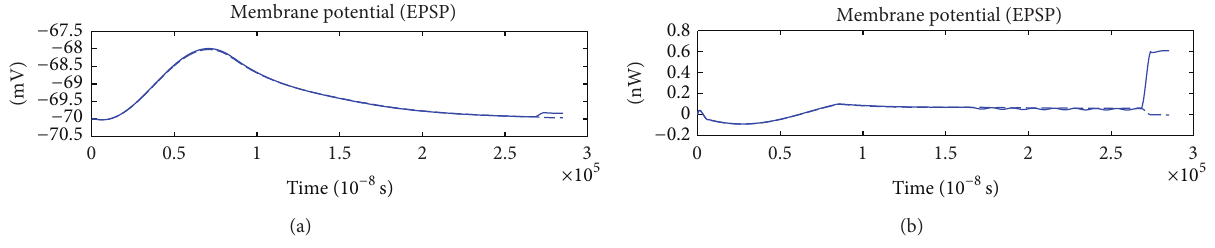
Figure 13: The EPSP and the corresponding energy function. 𝑟 0𝑚 = 0.0001 Ω , 𝑟 1𝑚 = 0.1 Ω , 𝑟 2𝑚 = 1000 Ω , 𝑟 3𝑚 = 0.1 Ω , 𝑟 𝑚 = 1000 Ω , = 1 𝜇 F, 𝐿 = 50 𝜇 H, 𝑖 = 7.155 𝜇 A, and 𝑄 = 1 × 10 −6 𝜇 A. 𝐶 𝑚 𝑚 0𝑚